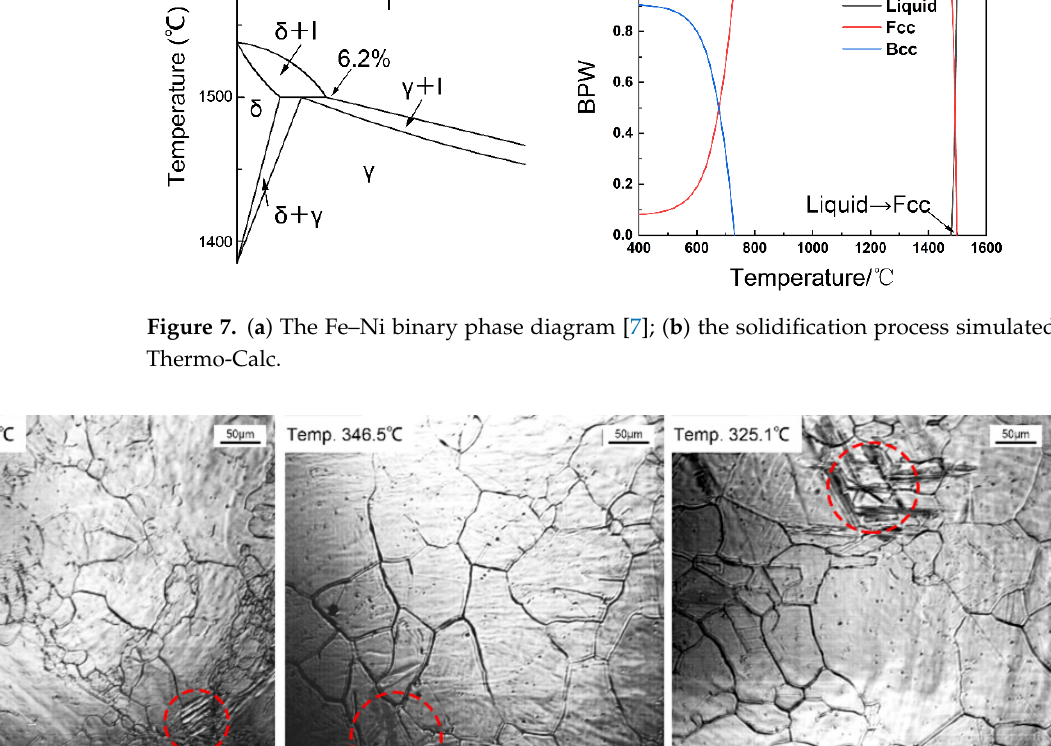
Figure 7. ( a ) The Fe–Ni binary phase diagram [7]; ( b ) the solidification process simulated by the Thermo-Calc.